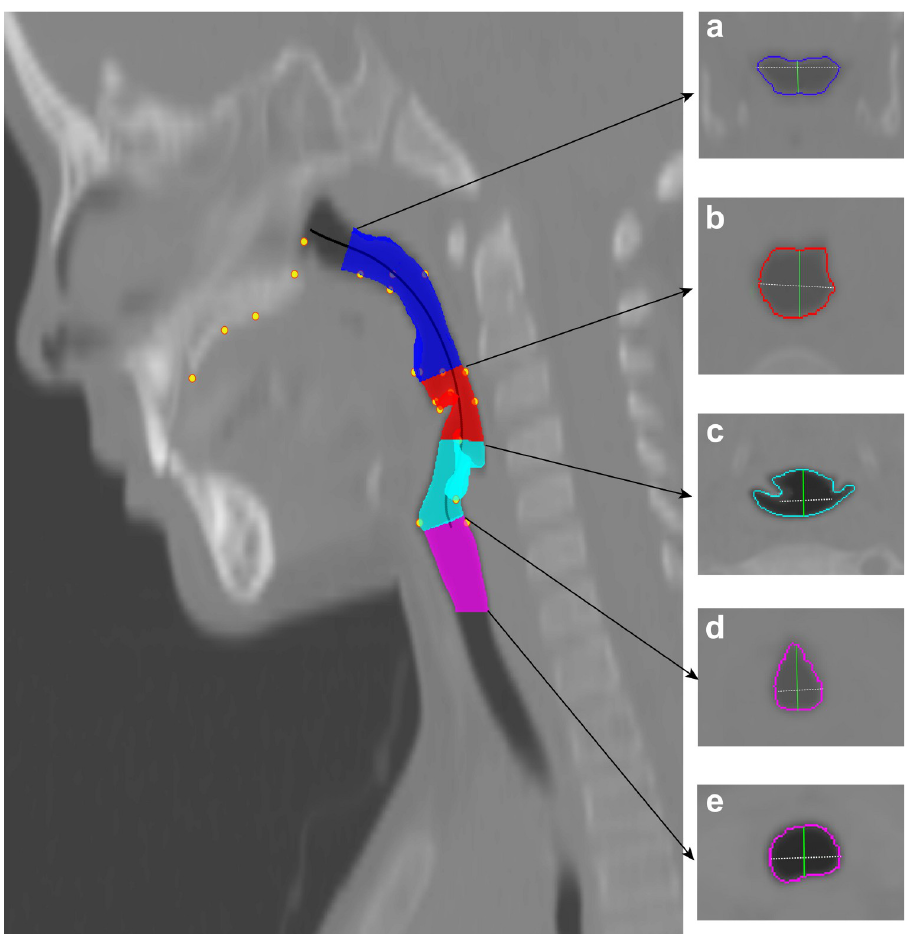
Fig 1. Illustration of airway regions and measurements. The airway was examined using landmark-derived planes orthogonal to the centerline, as described in text. The four airway regions bounded by five cross sectional areas, a-to-d as depicted in the right panel, were quantified developmentally using the following measurements: volume, region length, cross-sectional area (CSA), anterior-posterior distance, and lateral width—as defined in Table 5. The airway regions above the glottis (d; Table 5, definition 19), included the following pharyngeal regions: a. Nasopharynx (blue; definition 1); b. Oropharynx (red; definition 6); c. Laryngopharynx (cyan; definition 11); and the airway below the glottis consisted of the subglottal region (magenta; definition 22). The pharynx (Table 5, definition 16) consisted of all three supraglottal